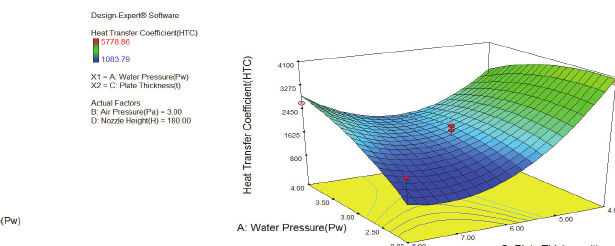
Fig. 2. Variation of HTC with respect to water pressure and air pressure